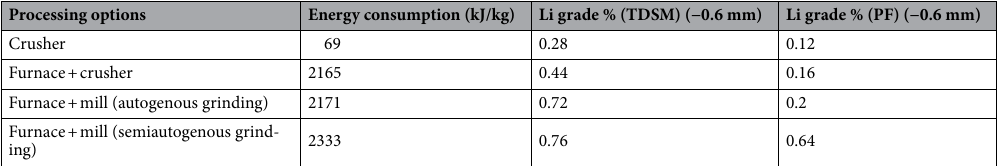
Table 4. Energy consumptions and lithium grade for −0.6 mm for different processing operations.